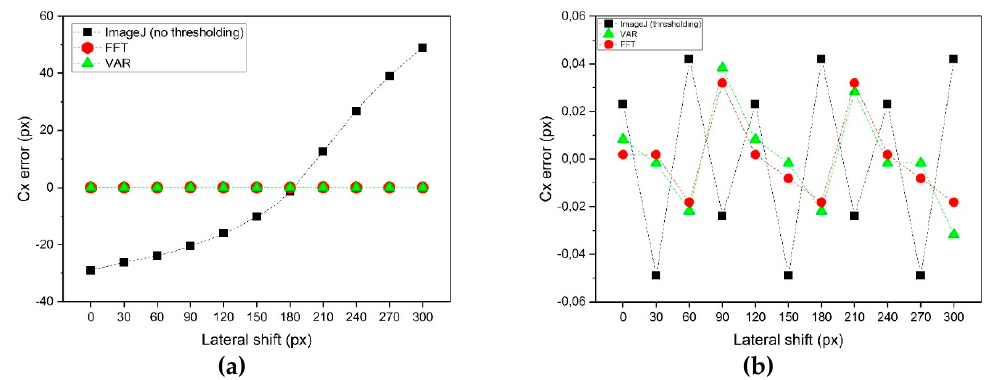
Figure 22. Error in the determination of the x-coordinate of the center as a function of the lateral shift of the sphere, when the sphere-camera distance is ~ 550 mm. ( a ): without ImageJ thresholding; ( b ): with ImageJ thresholding.